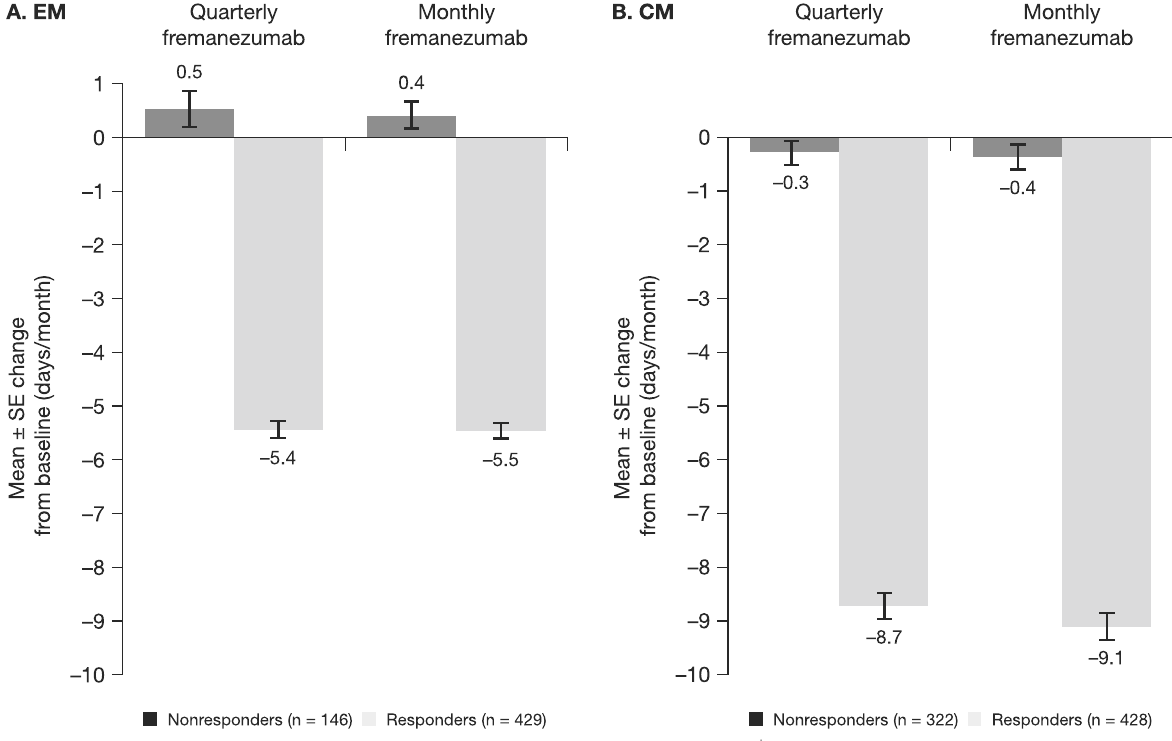
Fig. 2 Mean change from baseline in the MAMD among participants with ( a ) EM a and ( b ) CM b . CM, chronic migraine; EM, episodic migraine; MAMD, monthly average migraine days; SE, standard error. a For participants with EM, response was defined as a reduction of ≥ 2 MAMD. b For participants with CM, response was defined as a reduction of ≥ 4